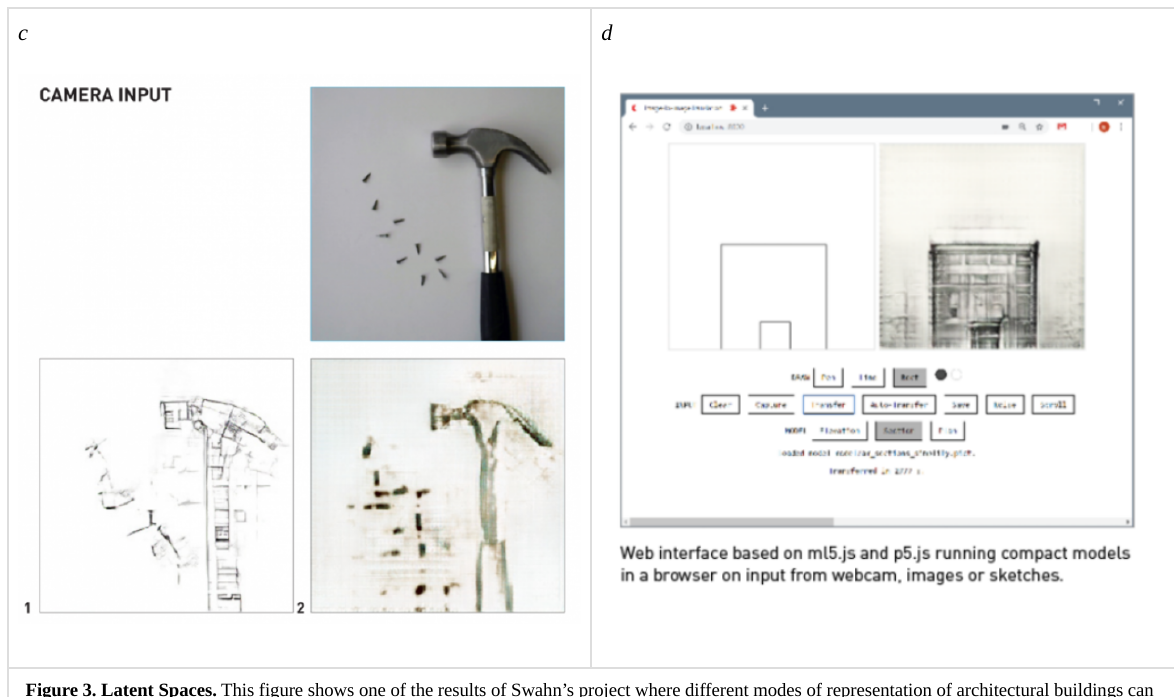
Figure 3. Latent Spaces. This figure shows one of the results of Swahn’s project where different modes of representation of architectural buildings can be translated (for example, sketches to plans, maps to plans, webcam images to plans, etc.). Erik Swahn, Latent Spaces . From: